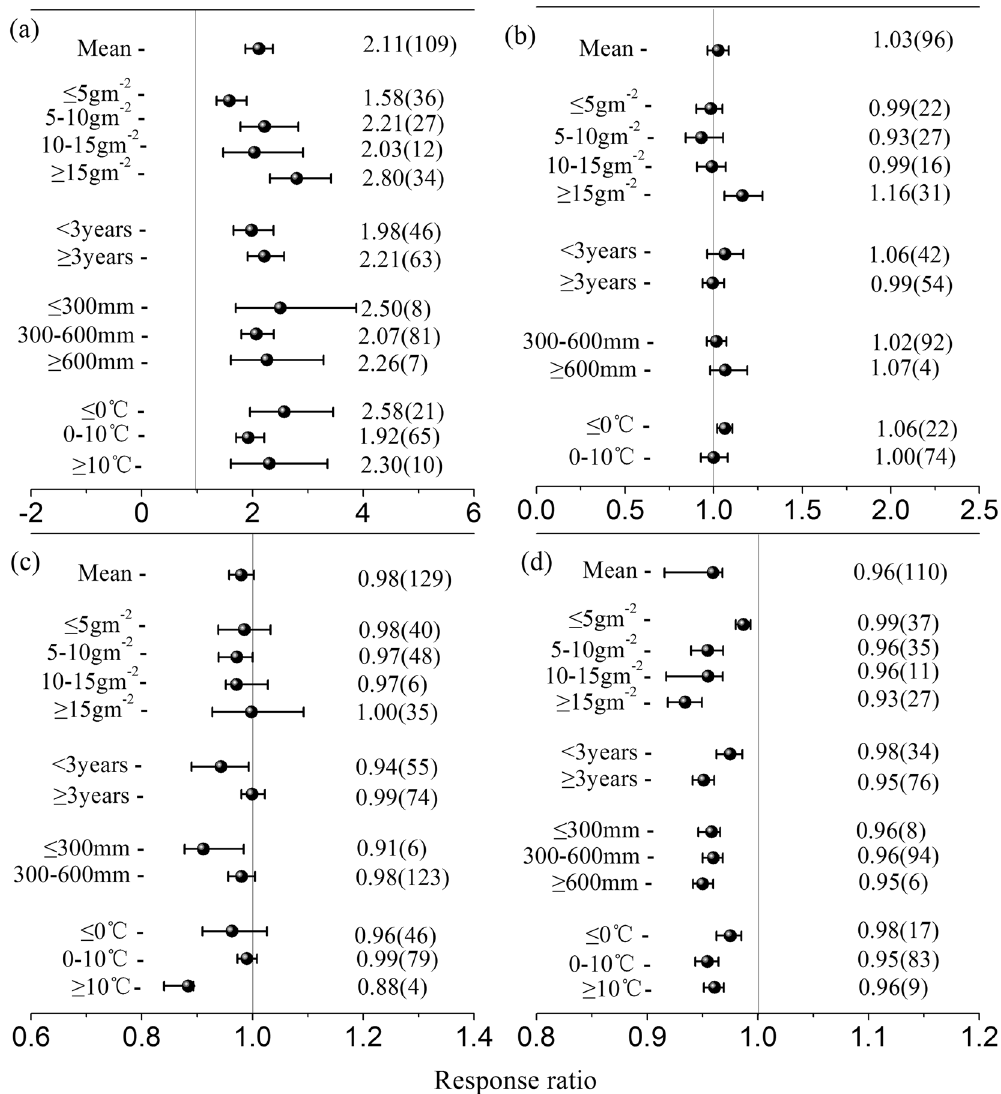
Figure 3. Effects of nitrogen (N) addition on soil available N concentrations ( a ), soil available phosphorus (P) concentrations ( b ), soil water content ( c ), and soil pH ( d ) under different N addition rates, study durations, and climatic conditions. The numbers outside and inside the parentheses represent the response ratio (RR) and the number of observations, respectively. The dots with error bars are the means with 95% confidence